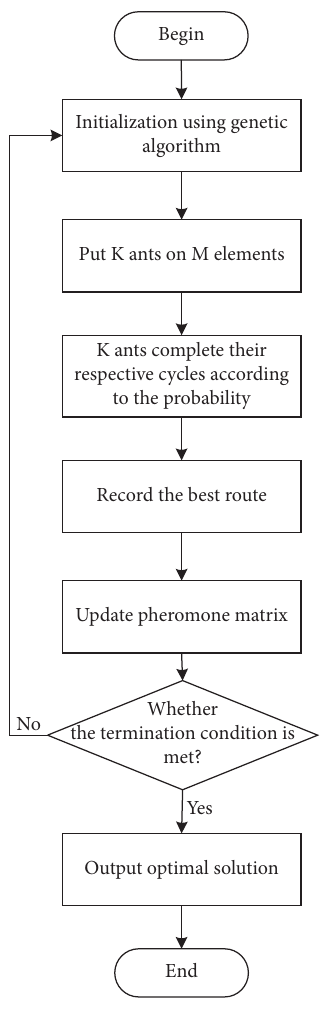
Figure 1: Flowchart of the improved ant colony